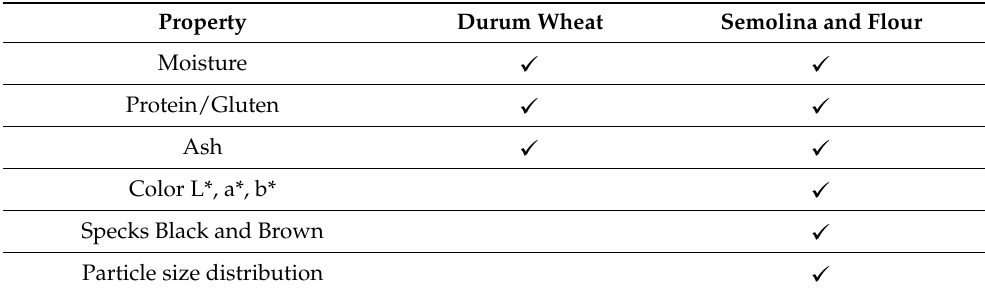
Table 8. Quality attributes measured online.